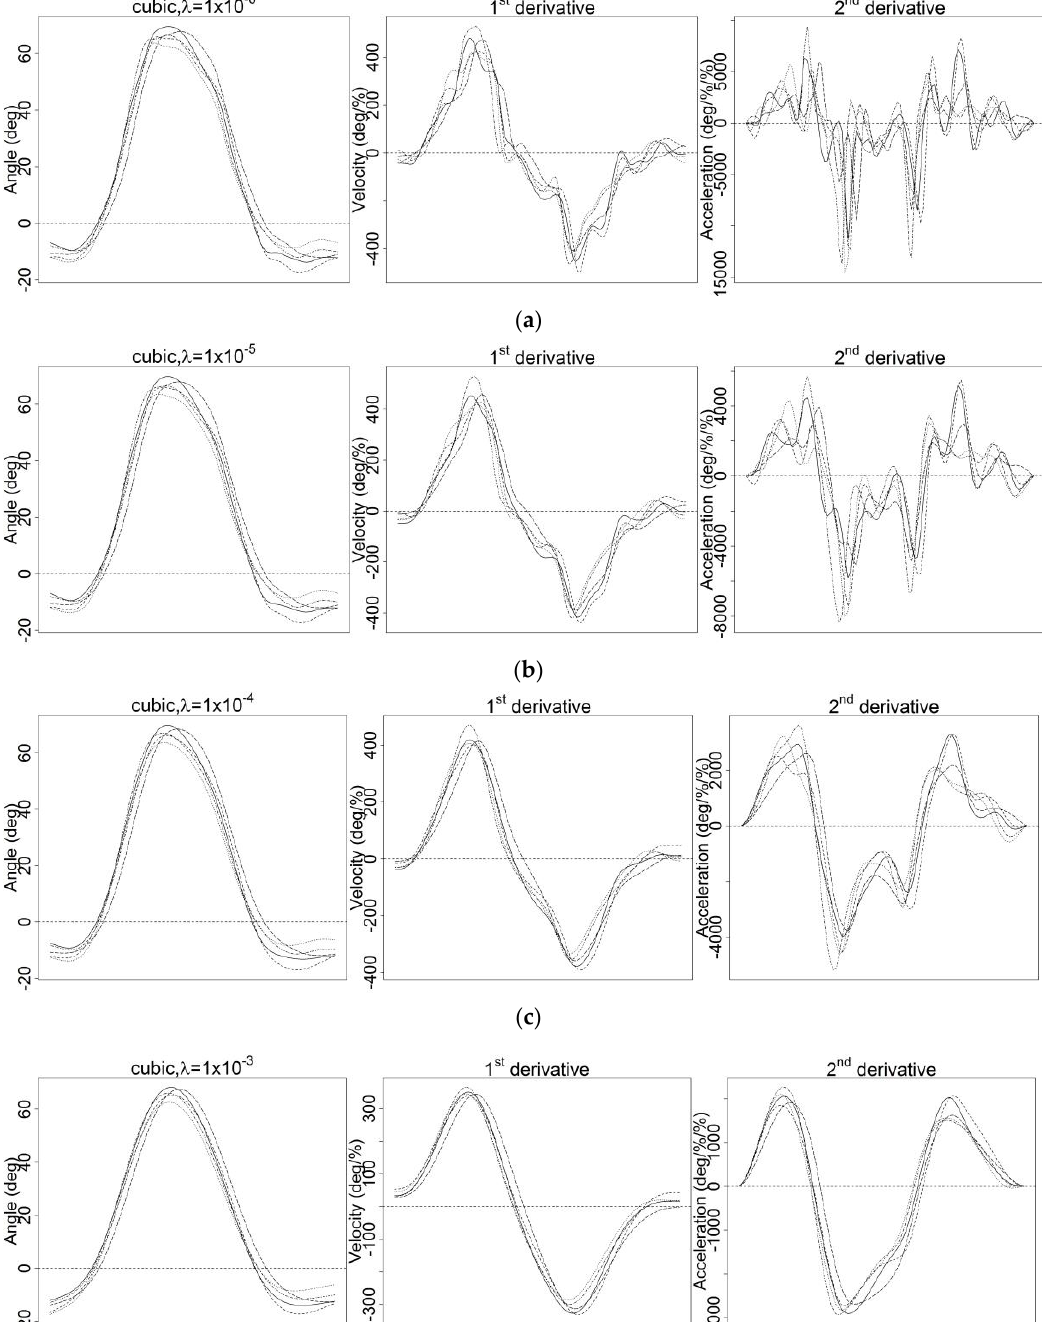
Figure A2. Smoothing with 8 1 10     obtained from using generalized cross-validation (GCV) method using ( a ) cubic spline basis and ( b ) quintic spline basis.